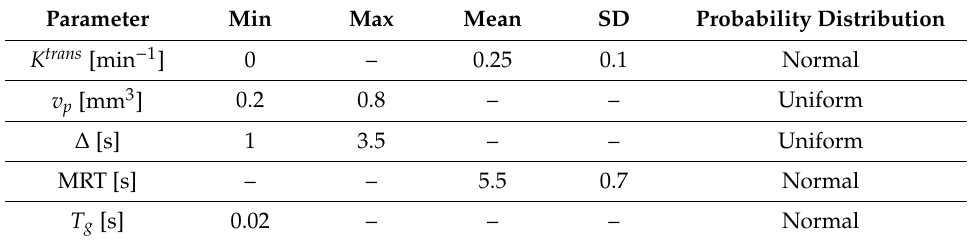
Table 1. Parameter limits and types of probability distributions used for sampling training data set for ANN (artificial neural network).